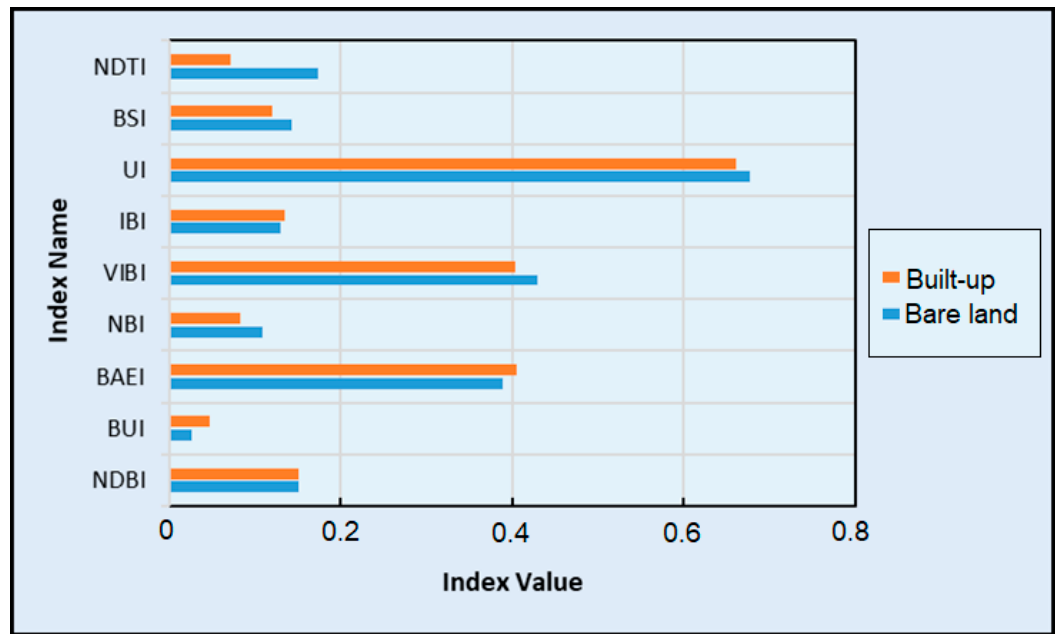
Figure 5. Comparison of the average index values of points on bare land and built-up classes.